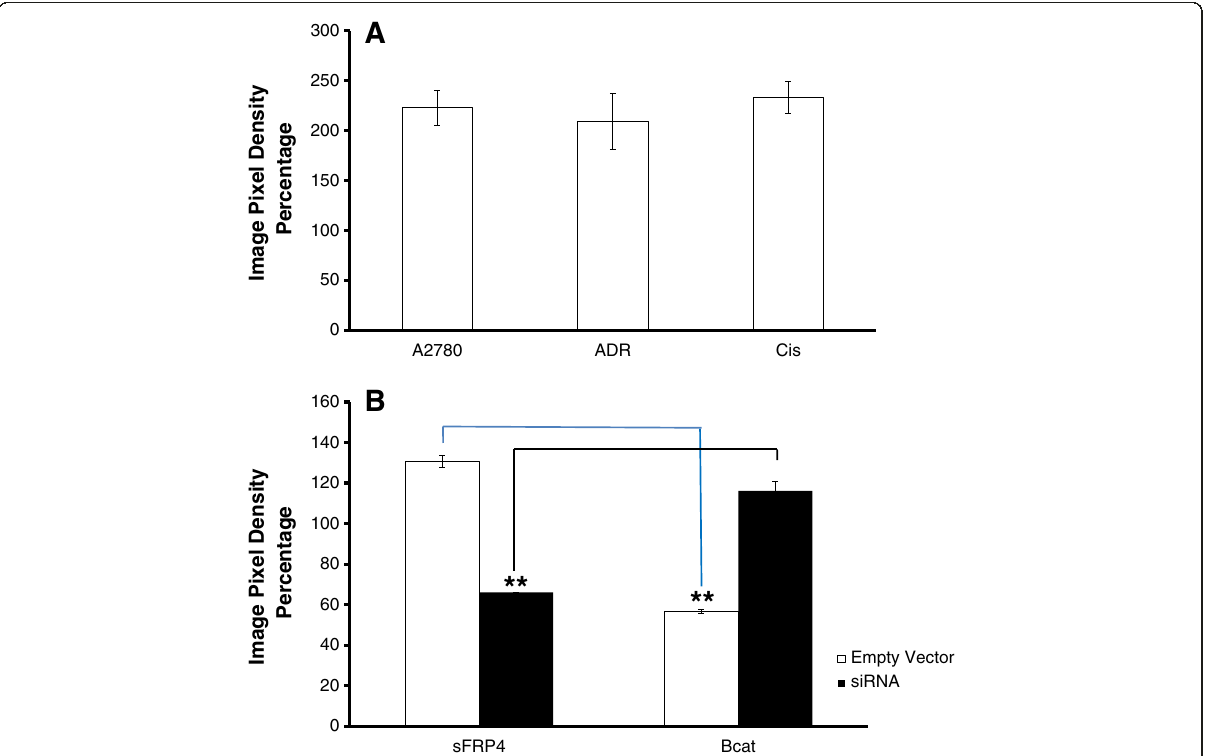
Figure 7 (A) β -catenin protein expression across the three cancerous cell lines. ( B ) Graphical representation demonstrating inverse sFRP4 and β -catenin protein expression following siRNA treatment in the chemosensitive cell line A2780. Values represent the mean for each group ± SEM. (** = p < 0.001 one way ANOVA and